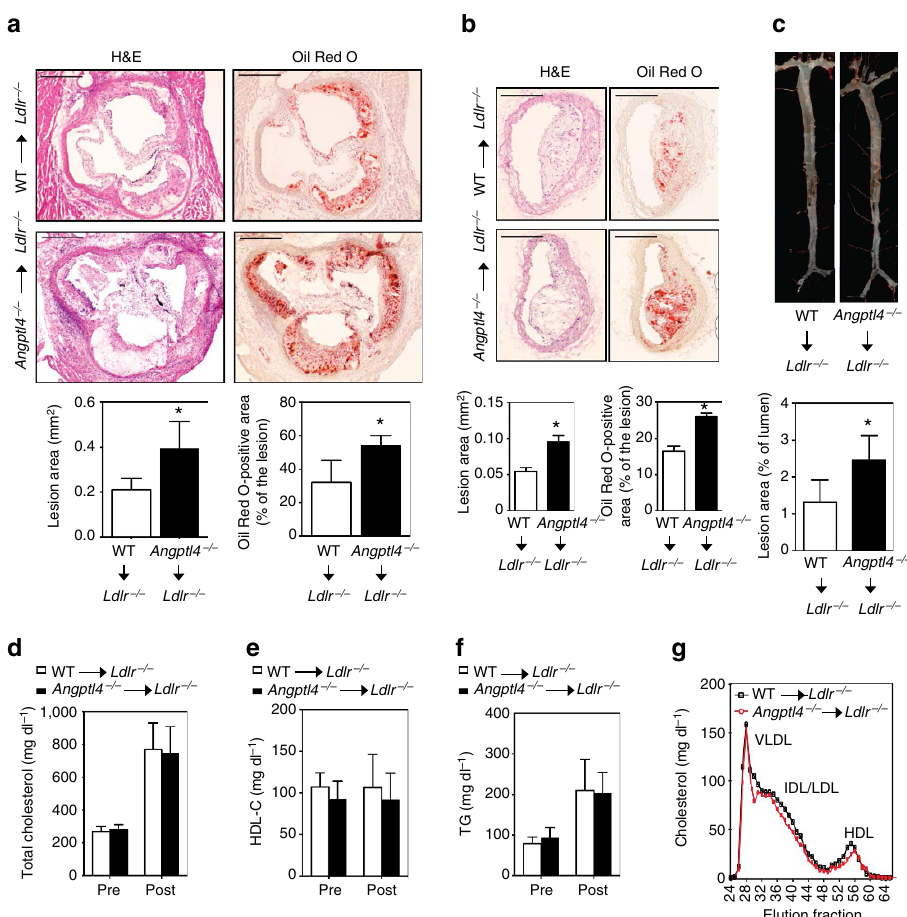
Figure 3 | Haematopoietic ANGPTL4 deficiency enhances atherogenesis. ( a , b ) Representative histological analysis of cross-sections of the aortic sinus ( a ) and brachiocephalic arteries ( b ) isolated from male Ldlr (cid:2) / (cid:2) chimeras with WT or Angptl4 (cid:2) / (cid:2) BM after 12 weeks of WD stained with H&E and Oil Red O. Quantification of lesion area and Oil Red O-positive lesion area is shown in the panel below respective figure ( n ¼ 10 per group for aortic sinus and n ¼ 6 per group for brachiocephalic arteries). Scale bars, 400 m m. ( c ) Representative pictures from en face analysis of aortas from Ldlr (cid:2) / (cid:2) chimeras with WTor Angptl4 (cid:2) / (cid:2) BM after 12 weeks on WD diet. Proportion of Oil Red O-positive area in the en face preparation is quantified in the lower panel ( n ¼ 8 per group). Total cholesterol level ( d ), HDL cholesterol level ( e ) and TG level ( f ) in the blood plasma of Ldlr (cid:2) / (cid:2) chimeras with WT or Angptl4 (cid:2) / (cid:2) BM before and after 12 weeks on WD ( n ¼ 10 per group). ( g ) Lipoprotein profile from pooled plasma ( n ¼ 5 each group) of Ldlr (cid:2) / (cid:2) chimeras with WTor Angptl4 (cid:2) / (cid:2) BM after 12 weeks on WD diet. All data are the mean ± s.e.m.; * P o 0.05 by comparison with data from Ldlr (cid:2) / (cid:2) chimeras with WT BM by unpaired t and BFU-E (erythrocyte, burst forming unit) (Fig. 6d). These results show the ability of Angptl4 (cid:2) / (cid:2) progenitors to grow mice. Angptl4 (cid:2) / (cid:2) BM had higher frequency of CMPs and lower